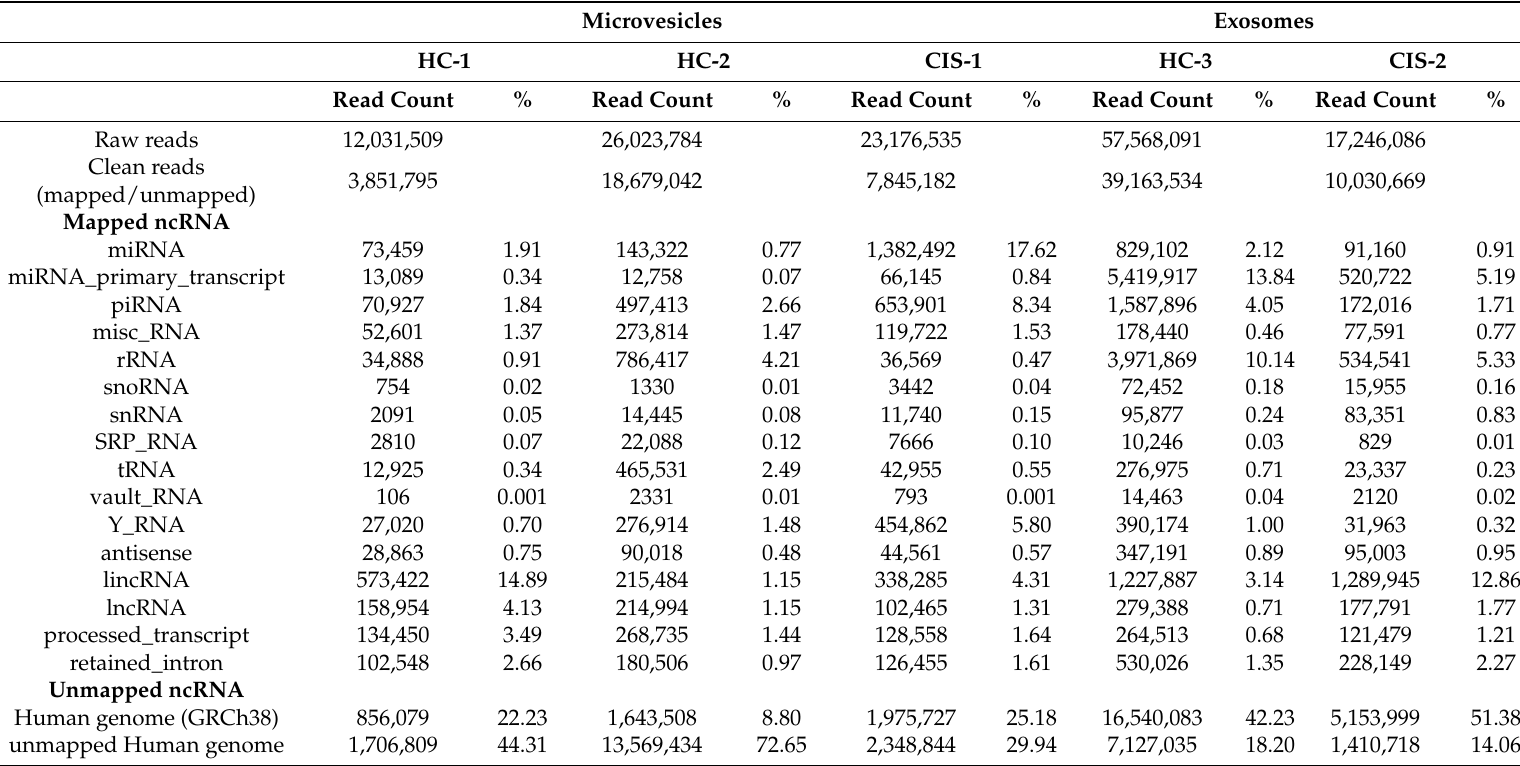
Table 1. Summary of the most representative small-RNA libraries in the examined extracellular vesicles (EVs) samples (no. 3 for microvesicles (MVs), no. 2 for exosomes